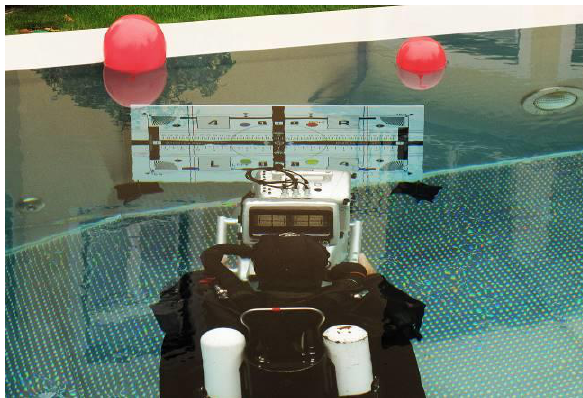
Figure 6. The first tests we made in the pool were very accurate and severe: here we are filming a chart using f 2.8 in order to be sure about the dome port quality